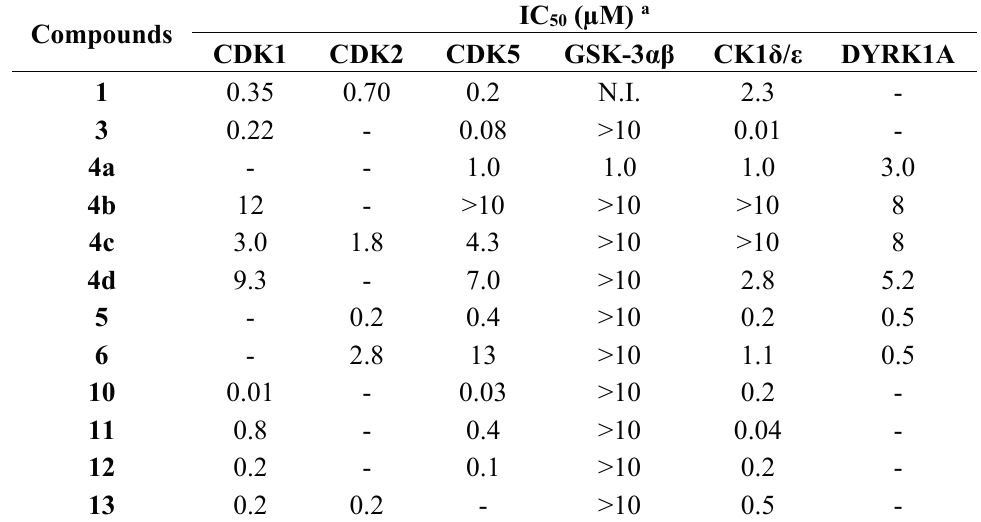
Table 1. Newly-synthesized trisubstituted purines effects on several mammalian protein kinases activity. Purine derivatives were tested at various concentrations as described in the experimental section; IC 50 values are provided in µM were estimated, dose-response curves and are expressed in µM. All assays were run in triplicates and data points were within less than a 10%